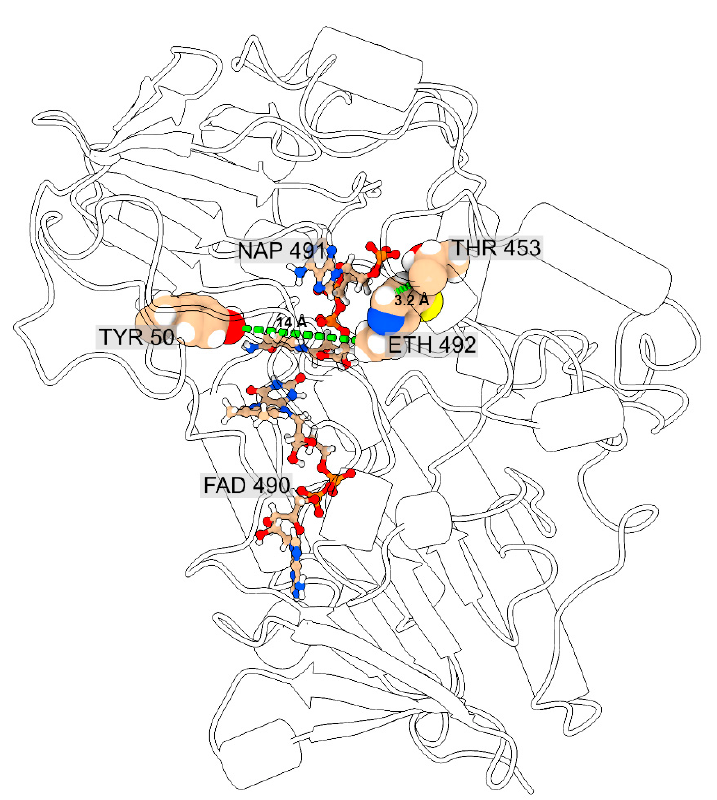
Figure 7. The spatial location of residues chosen for TI alchemical transformations in the most representative structure of EthA-14053 system. ETH is located at 14 Å and 3.2 Å from T50 and T453, respectively.